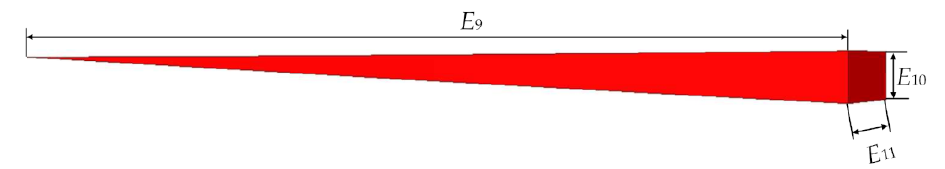
Figure 18. Schematic diagram of the position of size parameters on the initial segment of rifling. Table 4. The nominal values and tolerance intervals of size parameters. Size